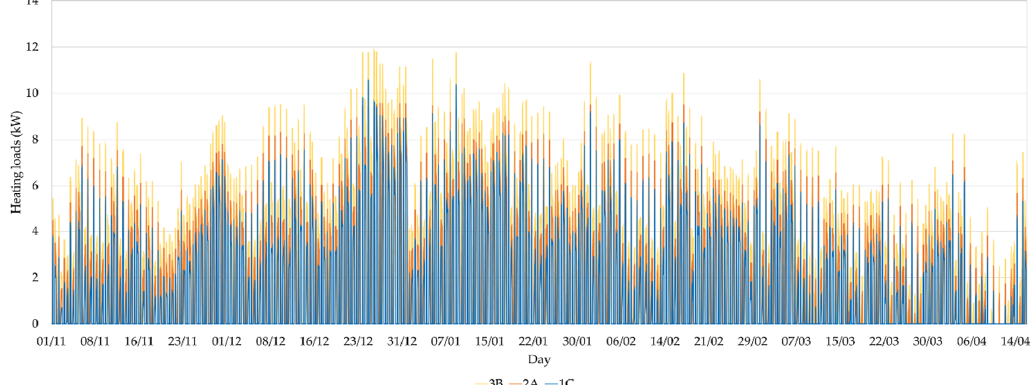
Figure 4. Simulated heating load of apartments 1C, 2A and 3B.